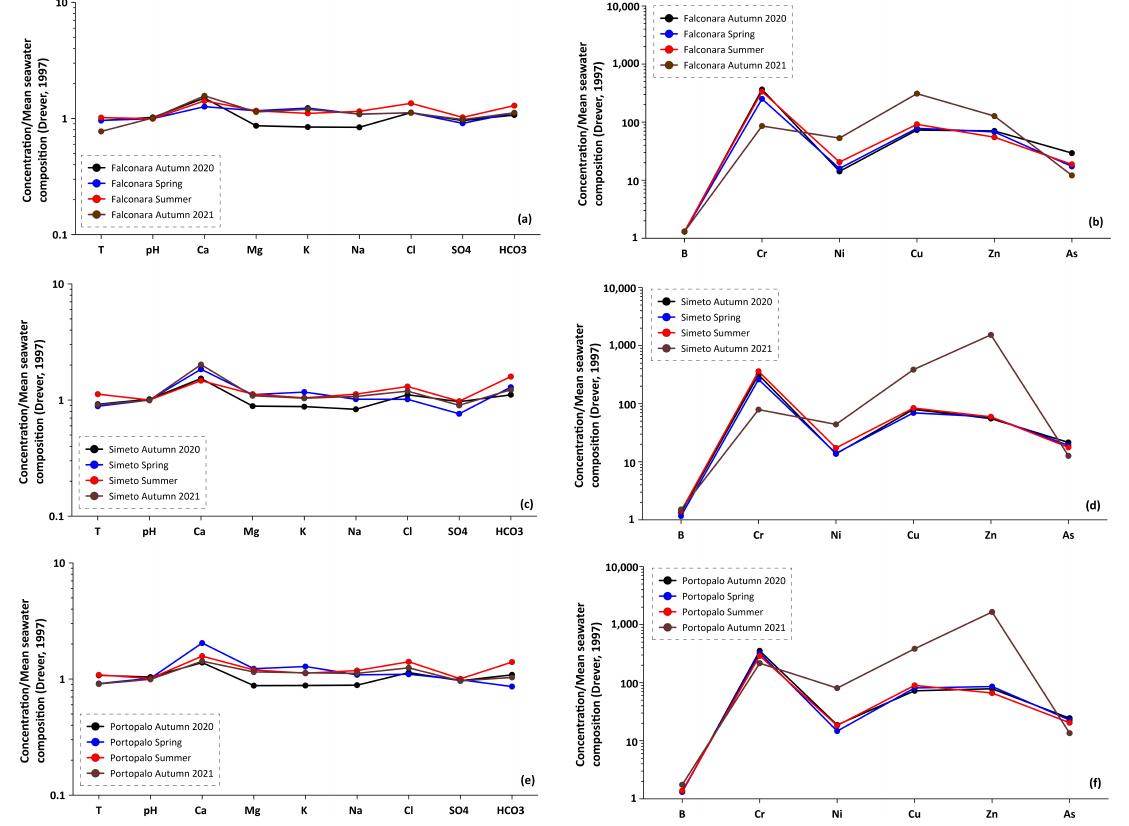
Figure 5 Figure 5. Mean seawater-normalized diagrams (data from [87]) of the physico-chemical parameters and major and trace constituents of samples collected at the Falconara ( a , b ), Simeto ( c , d ), and Portopalo ( e , f ) sites during Autumn 2021, Spring 2022, Summer 2022, and Autumn